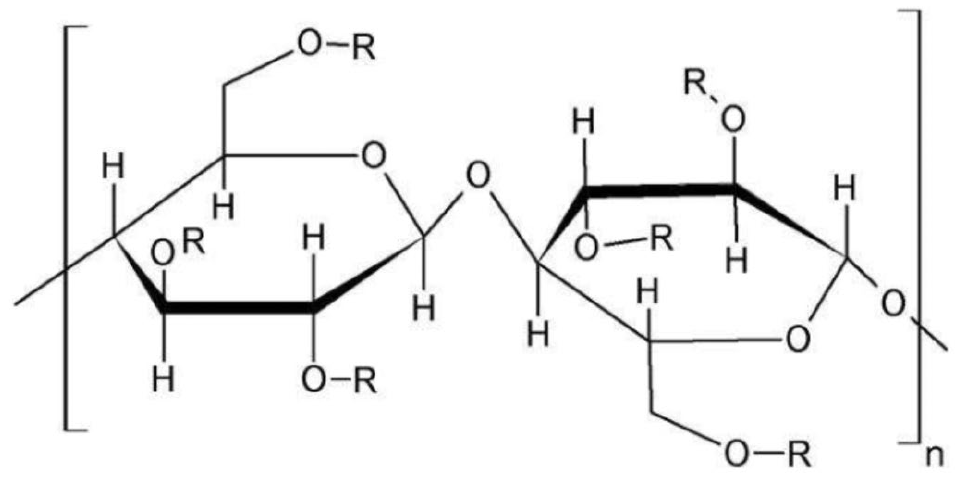
Figure 9. Represents the chemical structure of SCMC) [62].